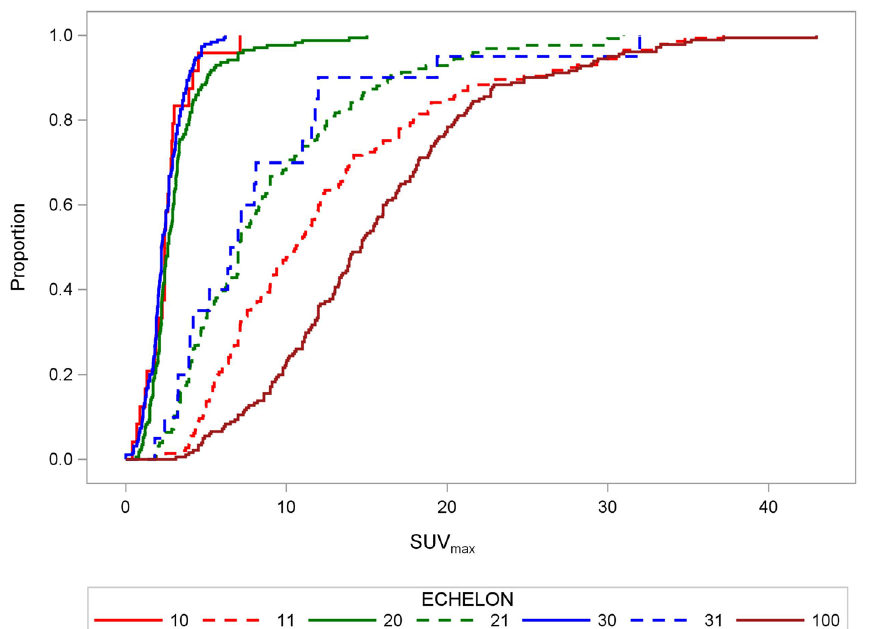
Figure 2. Empirical distribution functions of SUV max values in lymph nodes. Empirical distribution functions of SUV max in lymph nodes at the different echelons of the mediastinum, plotted separately for EBUS-positive and negative echelons. Group (1.0): echelon-1, EBUS-negative; Group (1.1): echelon-1, EBUS-positive; Group (2.0): echelon-2, EBUS-negative; Group (2.1): echelon-2, EBUS-positive; Group (3.0): echelon-3, EBUS-negative; Group (3.1): echelon-3, EBUS-positive; Group (10.0): primary tumour. The SUV max for the primary tumours or EBUS-TBNA involved LNs decreased significantly from the primary tumour to echelon-1 and echelon-2 lymph nodes ( P < 0.01, Kruskal–Wallis test), while the distributions of echelon-2 and -3 nodes did not